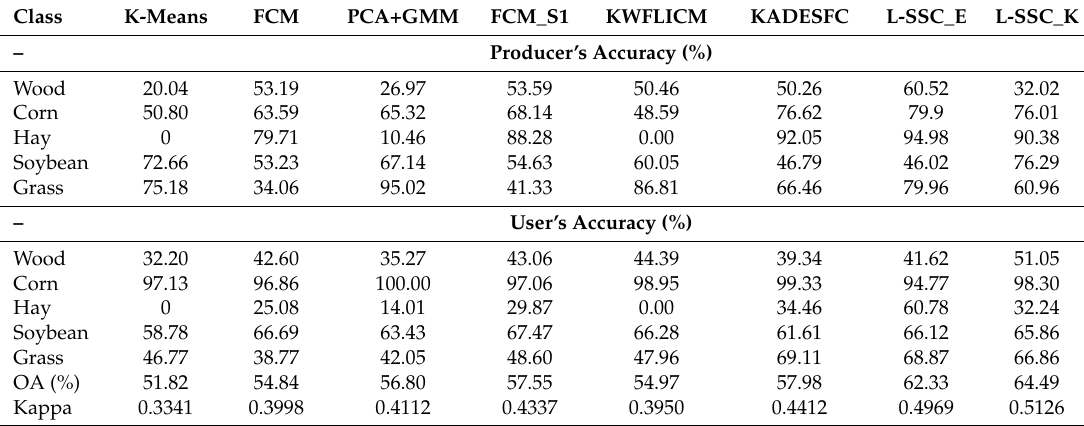
Table 6. Comparison of clustering accuracy for Indian Pine AVIRIS